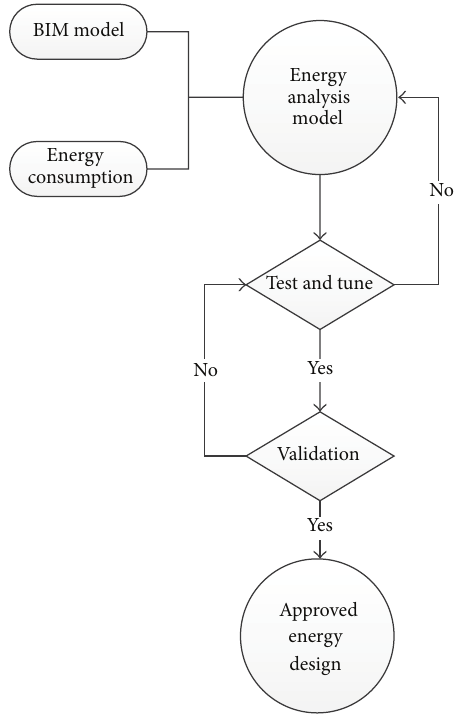
Figure 5: Framework of energy management design using